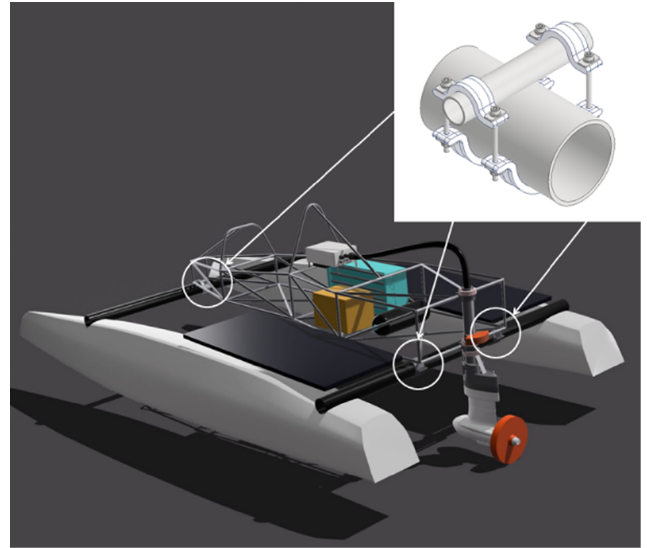
Figure 1. Additively manufactured FRP structural joint.